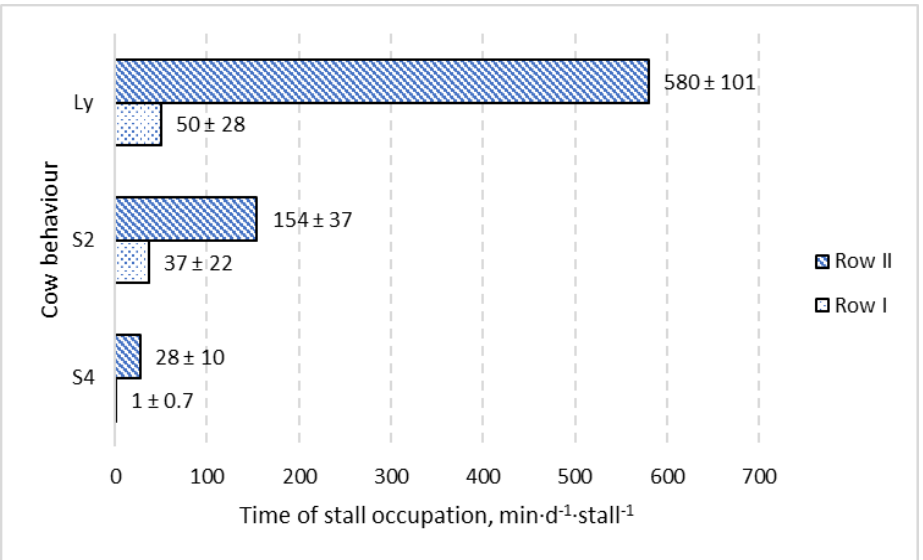
Figure 5. Comparison of time of stall occupation (mean ± SD) for two alternative rows (row I and row II) including three kinds of cow behaviour: lying (Ly), standing with two hooves in the stall (S2) and standing with four hooves in the stall (S4).